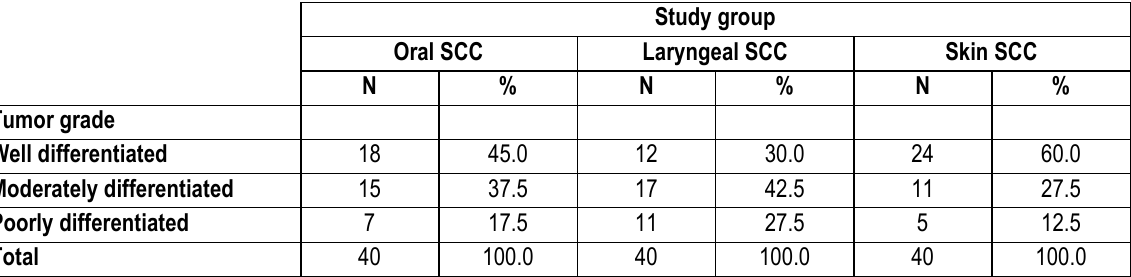
Table 2: Frequency distribution of the 3 study groups by tumor